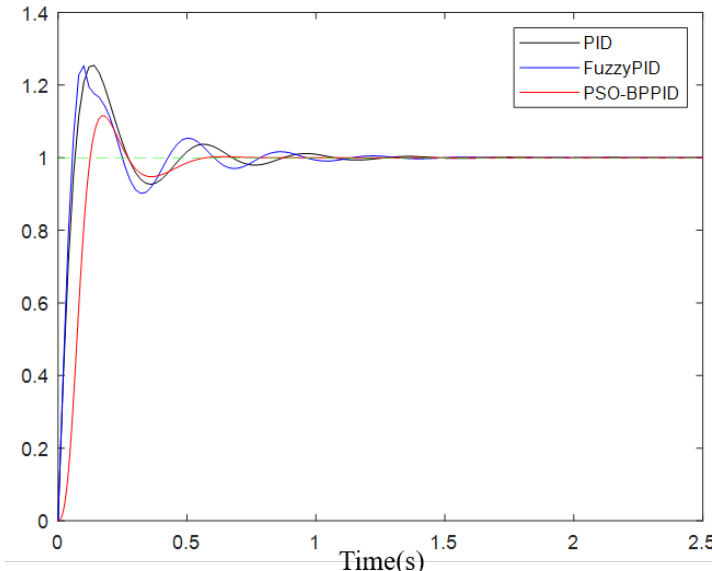
Figure 13. Comparison of time domain response curves. Table 3. Step response performance index comparison.